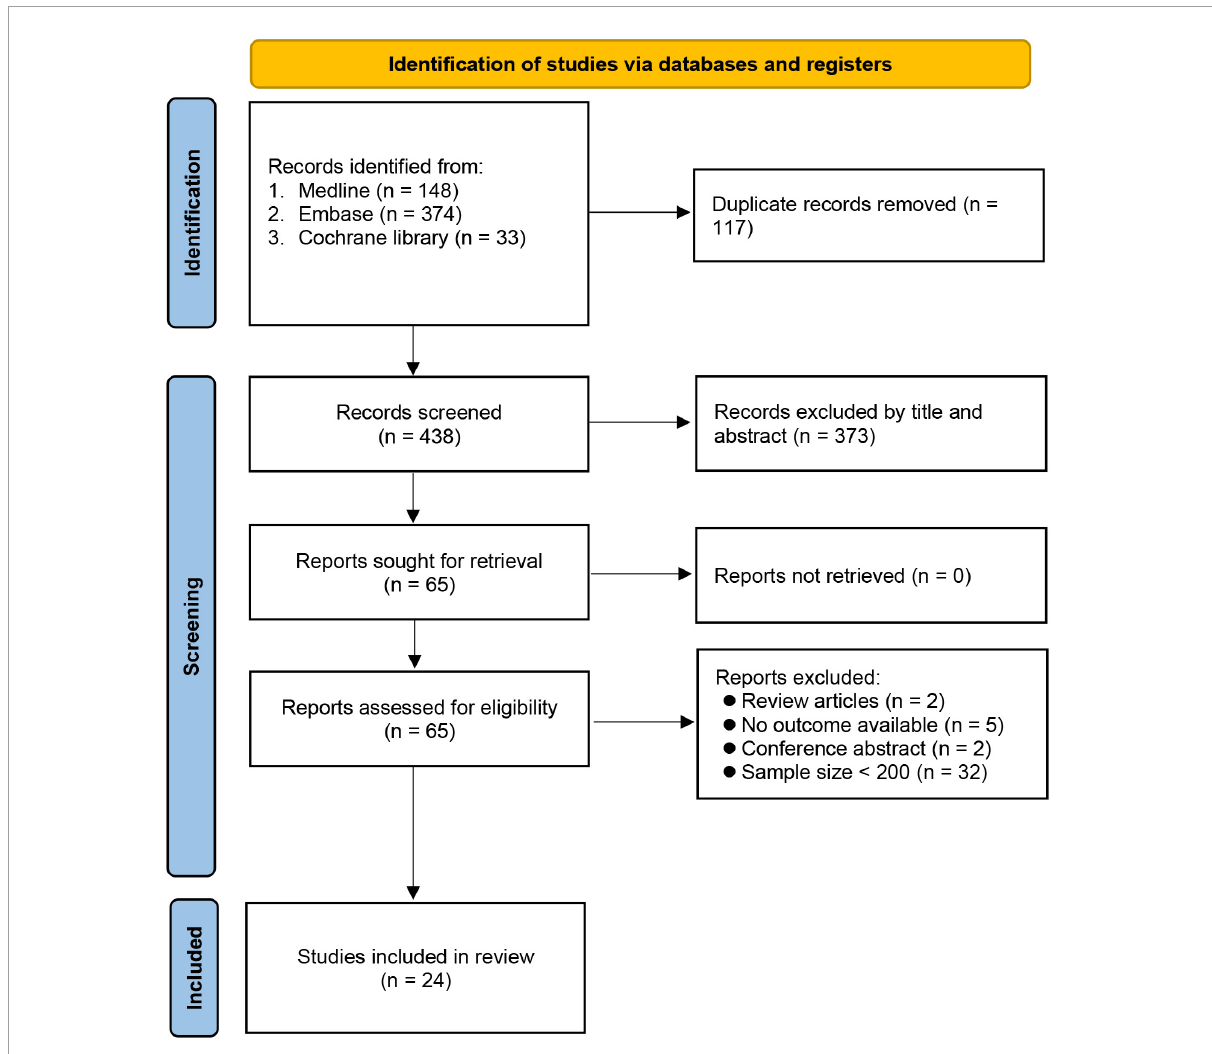
FIGURE1 PRISMA flow diagram of study selection for the current meta-analysis.